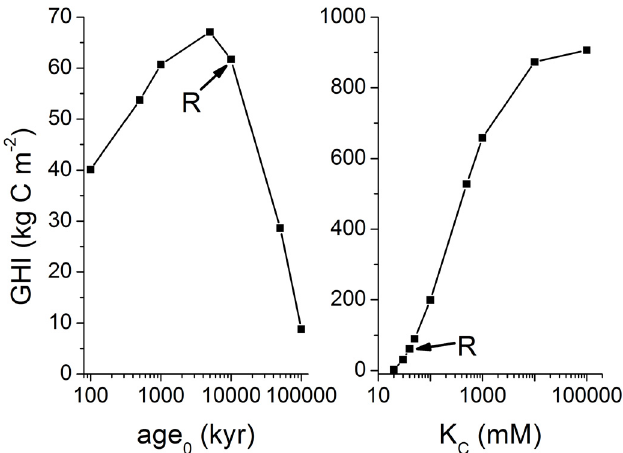
= 100 kyr. See legend of 0